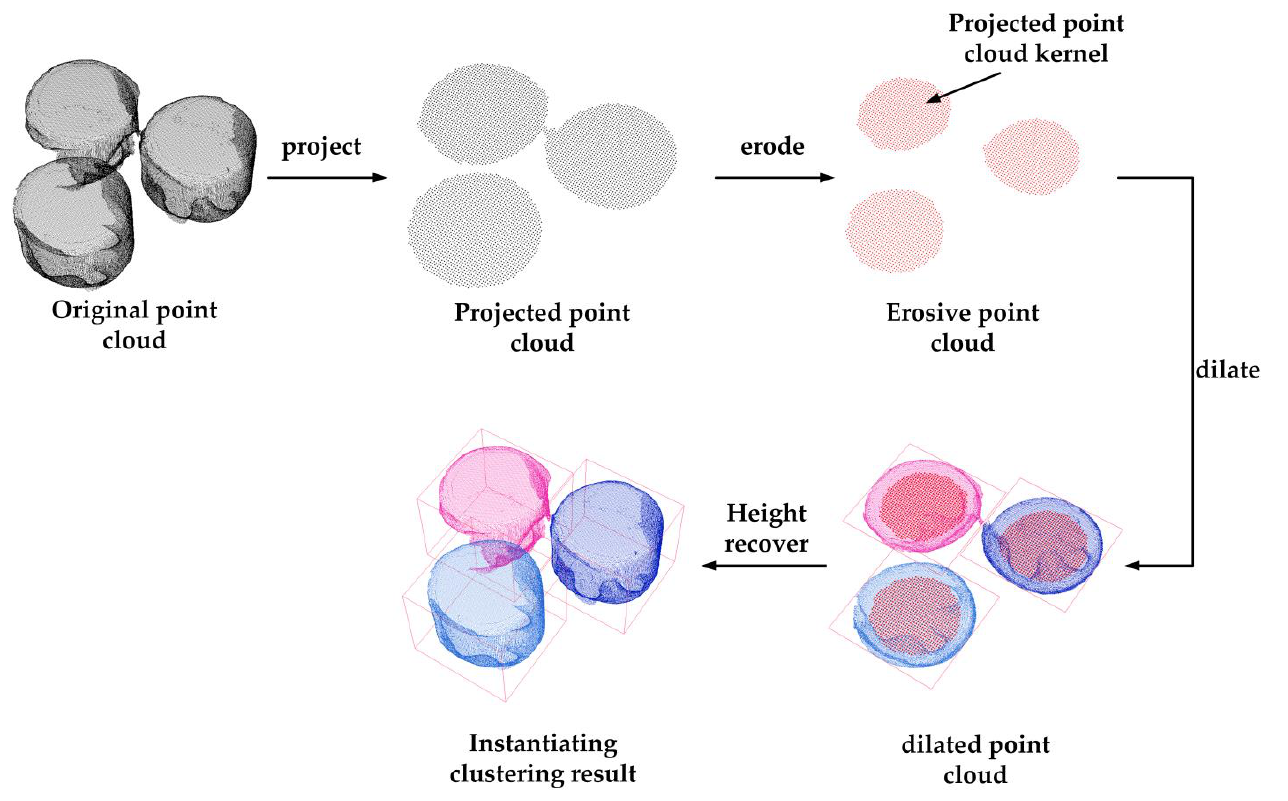
Figure 5. Flowchart of instantiating